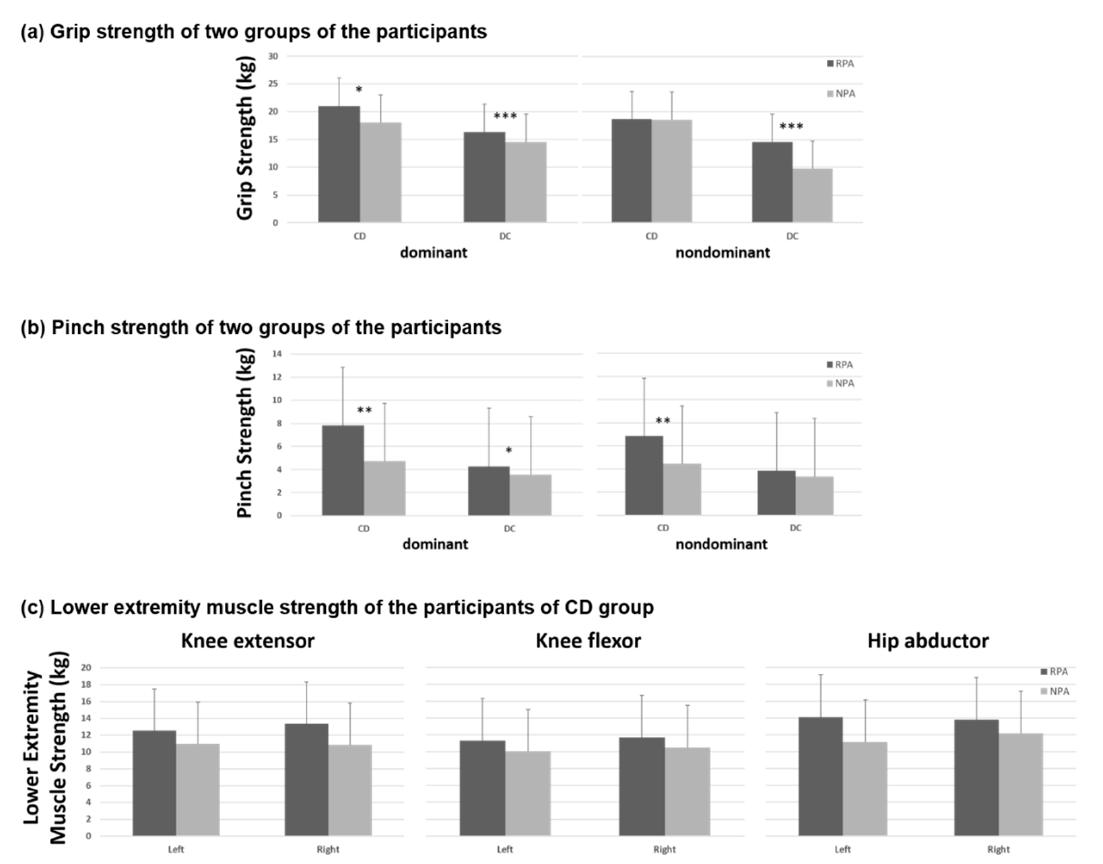
Figure 1. Muscle strength of ( a ) grip ( b ) pinch and ( c ) lower extremity of the participants; * p < 0.05; ** p < 0.05; *** p < 0.01. Table 4. The comparison of physical performance between the RPA and the NPA subgroups in DC group.